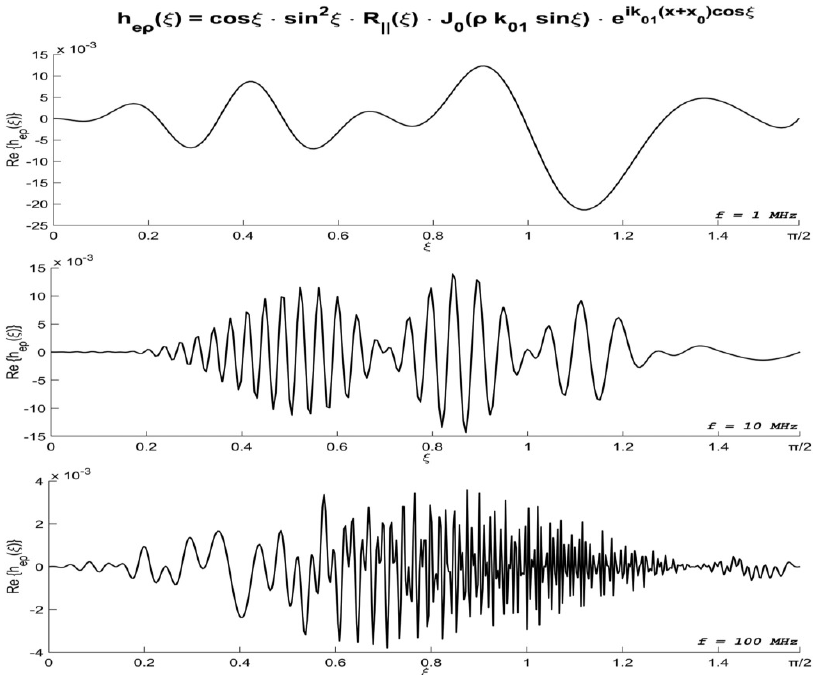
Figure 5. Electric field components at the frequency of 30 MHz.